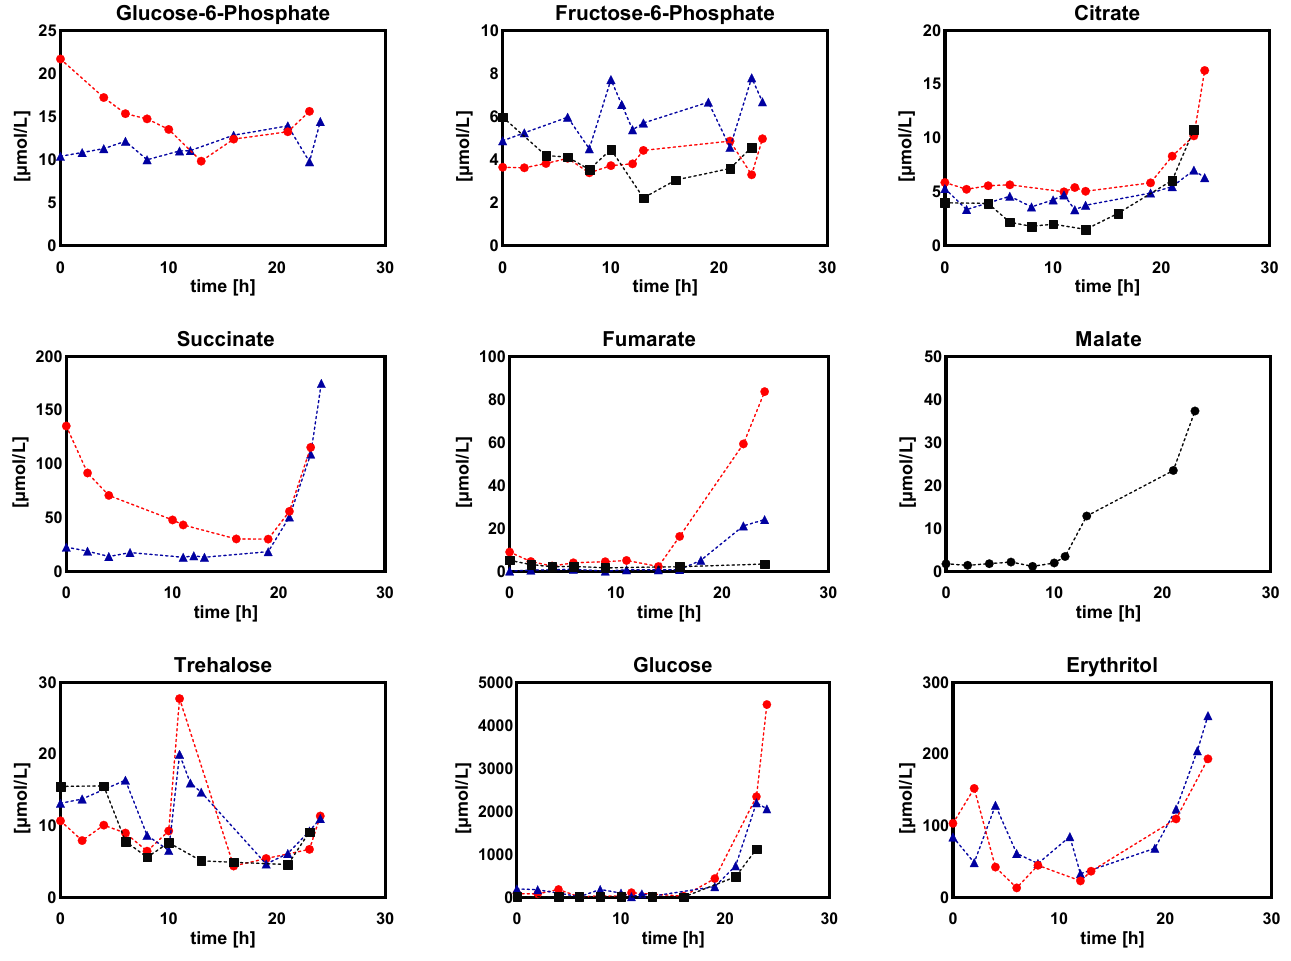
Figure 16. Extracellular concentrations of sugar phosphates, organic acids, and sugar alcohols in Penicillium chrysogenum Wisconsin 54-1255 under DO ramp-down experiments. The DO linearly decreases from 60% to 0% over 24 h. Time 0 represents the start of DO ramp-down. Different legends represent replicate